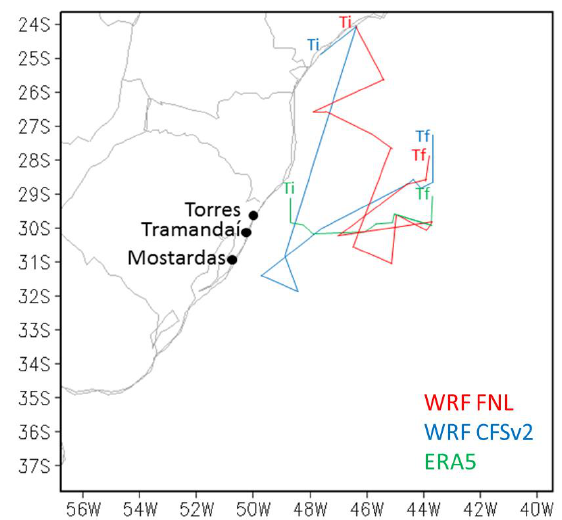
Figure 2. Cyclone trajectory between October 27 at 05 UTC ( Ti ) and October 28 at 05 UTC ( Tf ). The points indicate the location of the meteorological stations.